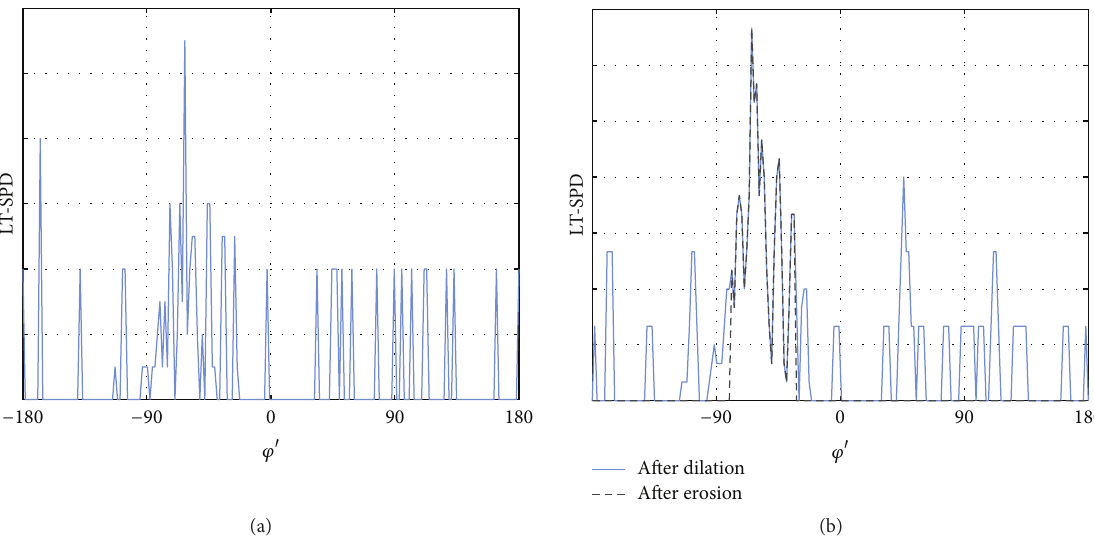
Figure 3: Exemplary LT-SPD when a speaker is active at − 80 ∘ . (a) Unprocessed LT-SPD. (b) LT-SPD after removing the diffuse sound power.